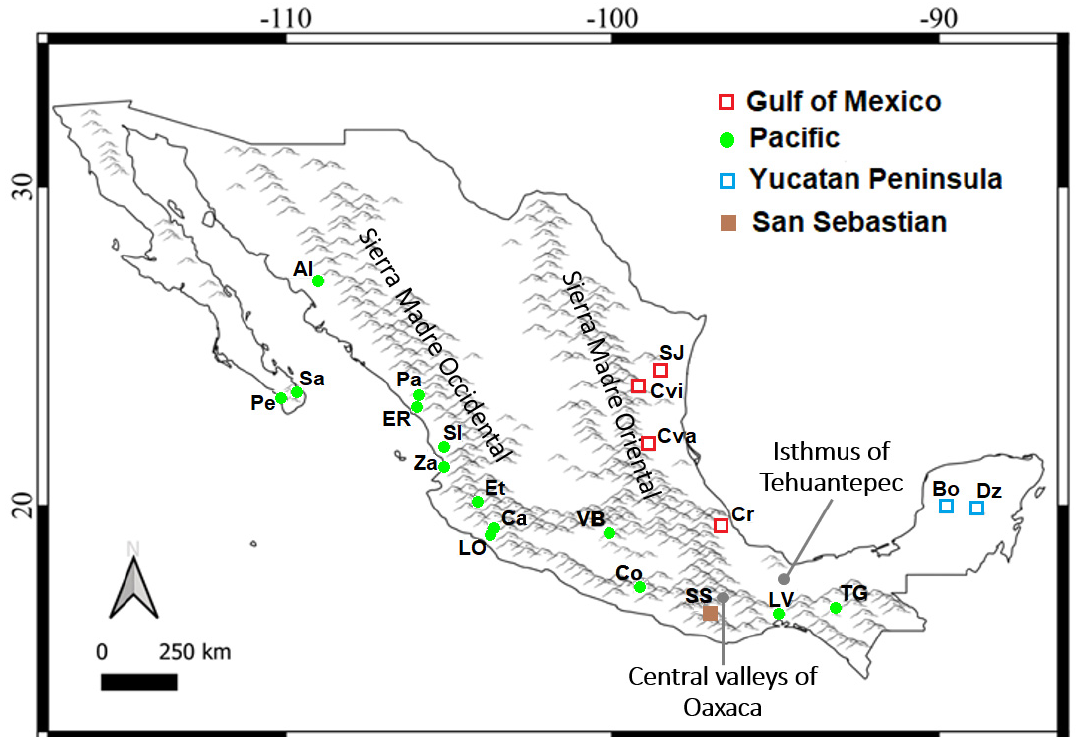
Figure 1. Map of the localities where samples of Natalus mexicanus were collected. Acronyms are as follows (locality, federal entity): Pe—Pescadero, B.C.S.; Sa—Santiago, B.C.S.; Al— Á lamos, Son.; Pa—P á nuco, Sin.; ER—El Rosario, Sin.; SI—Santiago Ixcuintla, Nay.; Za—Zacualpan, Nay.; Et—Etzatl á n, Jal.; LO—Los Ortices, Col.; Ca—Cardona, Col.; VB—Valle de Bravo, E. Mex.; Co—Colotipla, Gro.; SS—San Sebasti á n, Oax.; LV—La Venta, Oax.; TG—Tuxtla Guti é rrez, Chis.; Dz—Dziuch é , Q. Roo; Bo—Bolonch é n, Cam.; Cr—Carrizal, Ver.; Cva—Ciudad Valles, S.L.P.; Cvi—Ciudad Victoria, Tam.; SJ—Santander Jim é nez, Tam. Symbols indicate the groups derived from genealogical analyses; major historical geographic barriers are indicated.